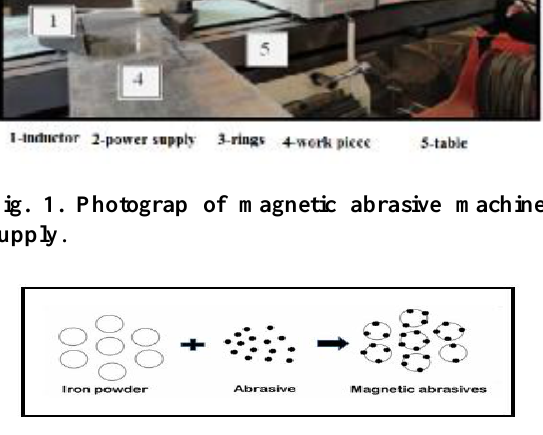
Fig. 2. Schematic of mechanical alloying.